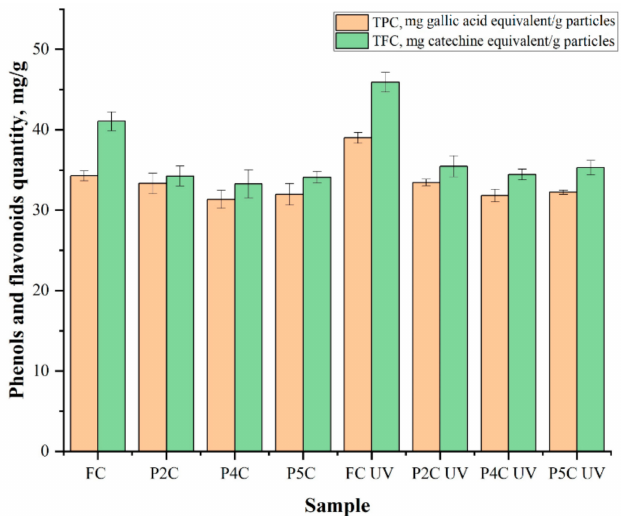
Figure 9. The total content of phenols (orange) and flavonoids (green) in free curcumin (FC) and the curcumin extracted from the P2C, P4C, and P5C samples that were irradiated and non-irradiated with UVA. Results were expressed as mean value ± standard deviation (SD). The samples exposed to UVA light were noted with P2CUV, P4CUV, or P5CUV and